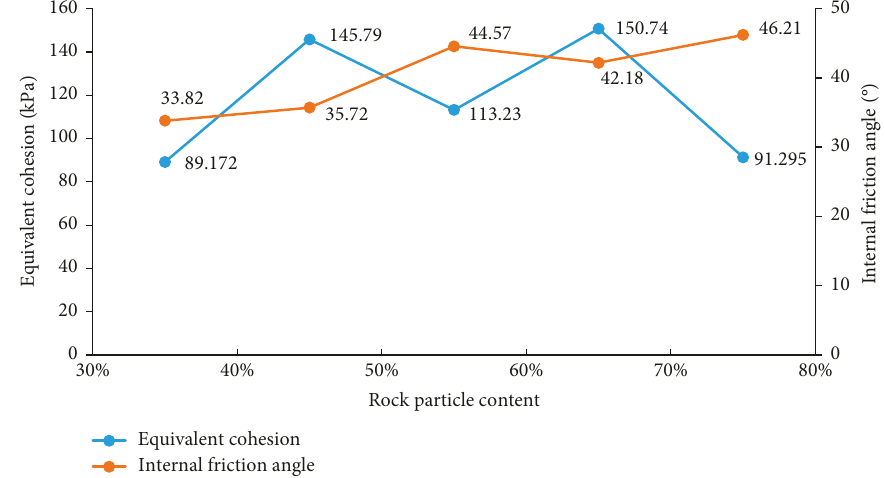
Figure 12: Curves of the equivalent cohesion and the internal friction